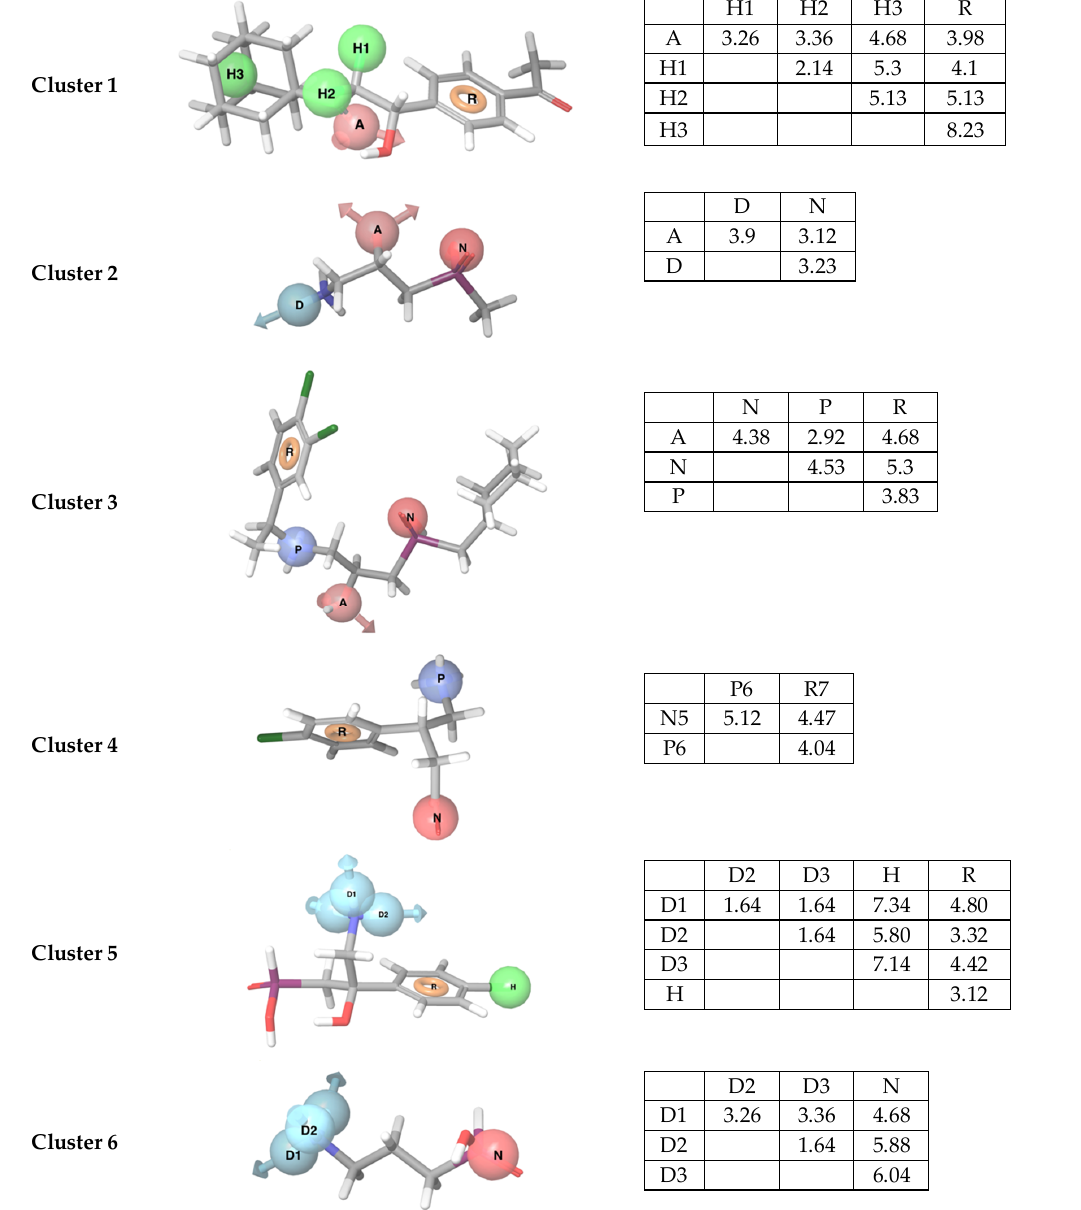
Figure 1. Pharmacophore models obtained from each cluster with the matrix of distances (Å) between features. The best mapped compound for cluster 1–6, CHEMBL2322934, CHEMBL113348, CGP54626, baclofen, 27 and CHEMBL112203, respectively, are displayed. Feature abbreviations; hydrophobic feature: H, hydrogen bond acceptor feature: A, hydrogen bond donor feature: D, aromatic feature: R, positively charged feature; P, and negatively charged feature: N.